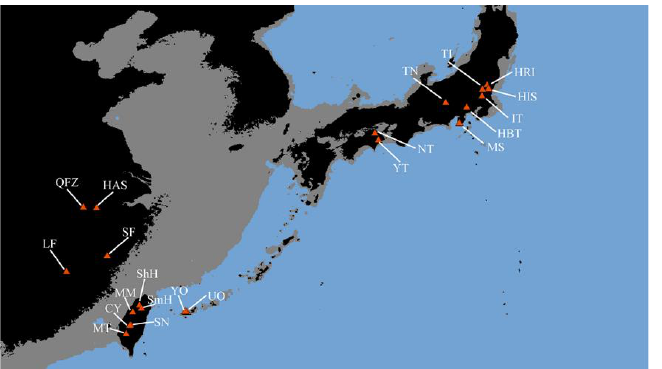
Figure 1. Locations of C. ramondioides sample collection. Samples were marked with abbreviations corresponding to those in Supplementary Table S1. Shaded sea areas indicate continental shelves that might have been exposed during the last glacial maximum.